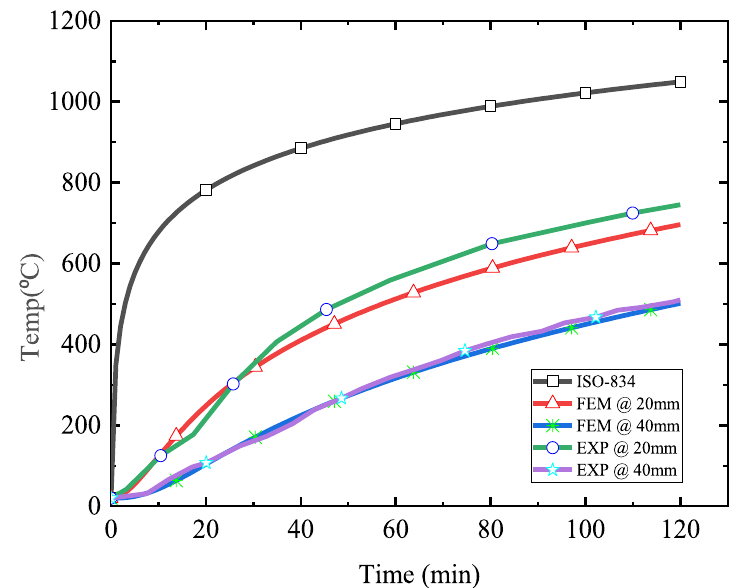
Fig. 31 Temperature distributions at different locations from heated surface